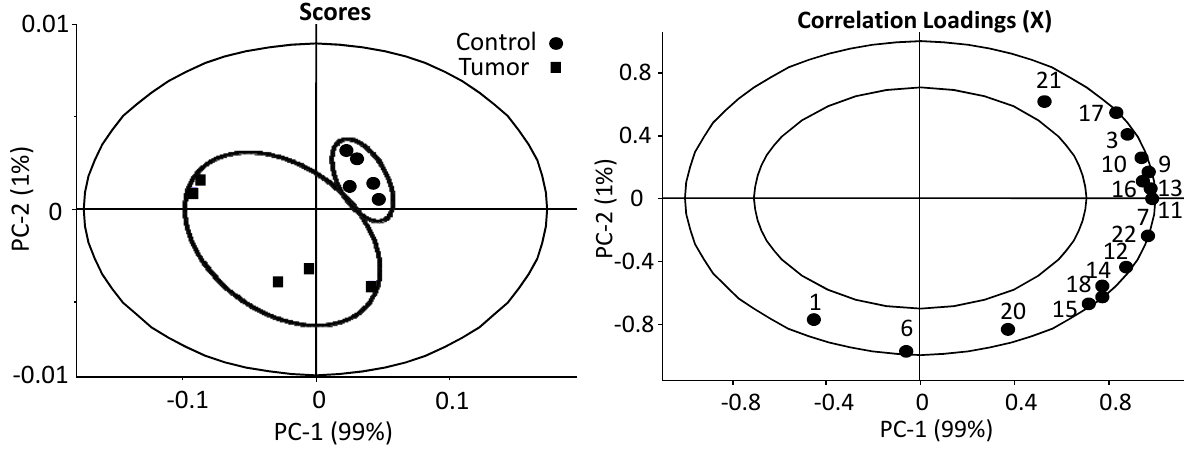
Figure 5. PCA analysis of the estimates of the absolute concentrations of lipid soluble metabolites from liquid state 1 H-NMR, Different metabolites are labeled using the same numbers as in Figure 2. The only elevated lipid soluble metabolite in the tumor group is the cholesterol (peak 1), with negative correlation loadings in PC-1 axial. All other lipid metabolites, including glycerol backbone (peaks 17 and 21), linear lipid groups 7 (methylene), 9 (CH CH CO), 13 (Choline N(CH ) ), 15 (Phosphatidylcholine N-CH ), 2 2 3 3 2 18 (Phosphatidylcholine PO-CH ) and 22 (lipids CH=CH) are decreased according to the 2 positive correlation loadings in PC-1. This result clearly indicates that the estimates of absolute concentrations of linear lipids including choline are decreased, while the cholesterol levels are increased in the metastatic melanoma group. (number of samples in model) N = 10, (number of variables) K = 17, (number of latent components) A = 7, (model fit) R 2 = 0.98, (predictive ability) Q 2 = 0.96. The insider circle with radius r = 0.5, the outer one r =